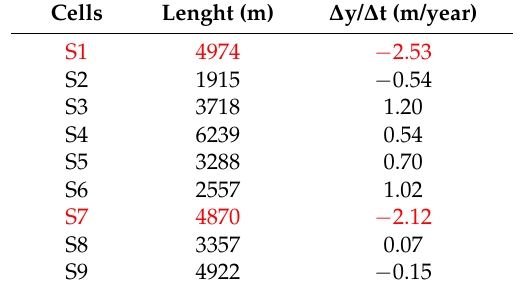
Table 2. Long term shoreline change rates, from 1986 to 2014, of coastal cells S1–S9 (hot-spots are evidenced by red color).